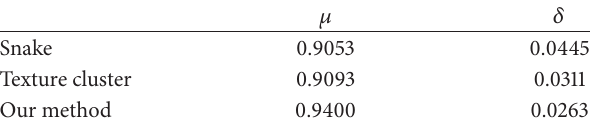
Table 1: Disc segmentation